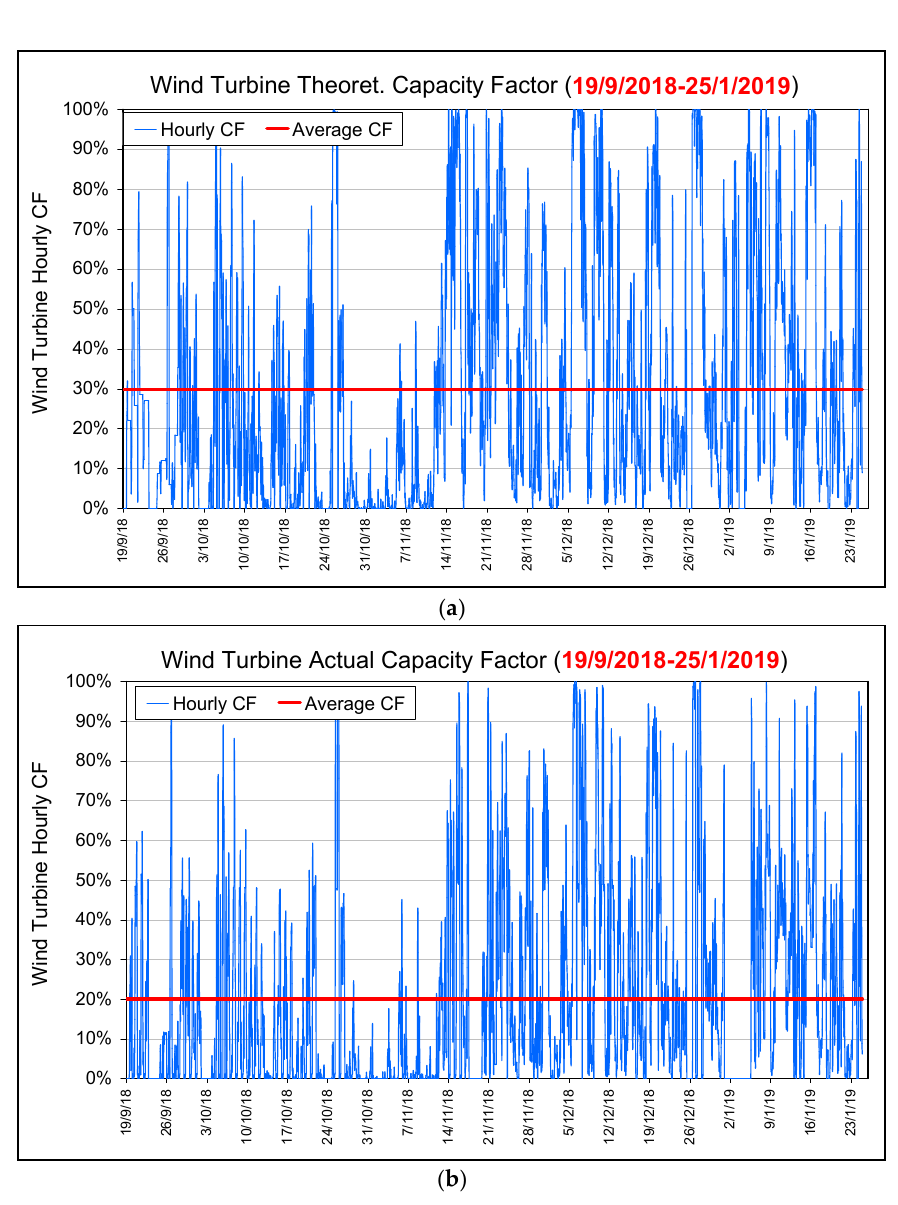
Figure 20. ( a ) Theoretical; ( b ) actual wind capacity factor over TILOS demonstration stage.